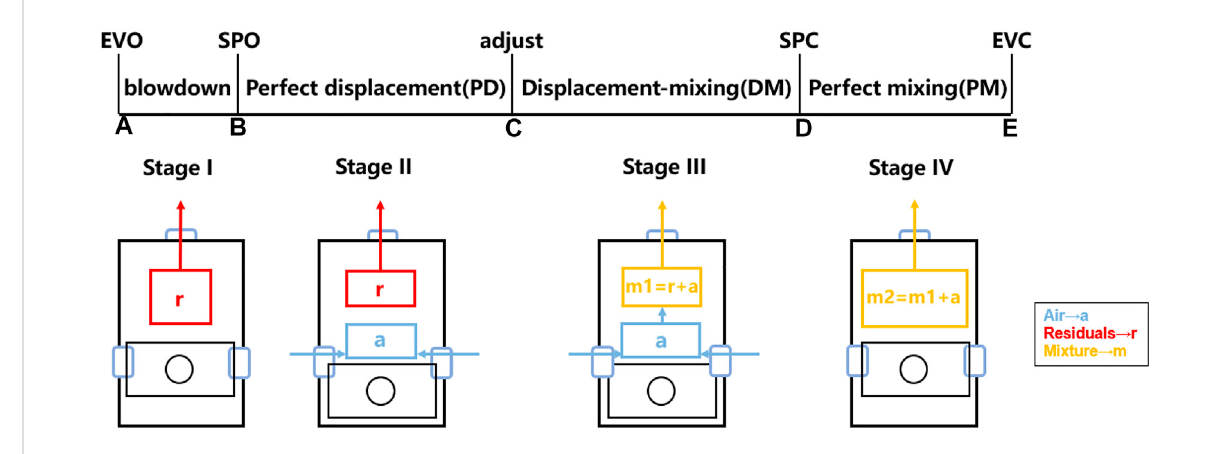
FIGURE 1 Schematic diagram of the zero-dimensional multi-stage model.